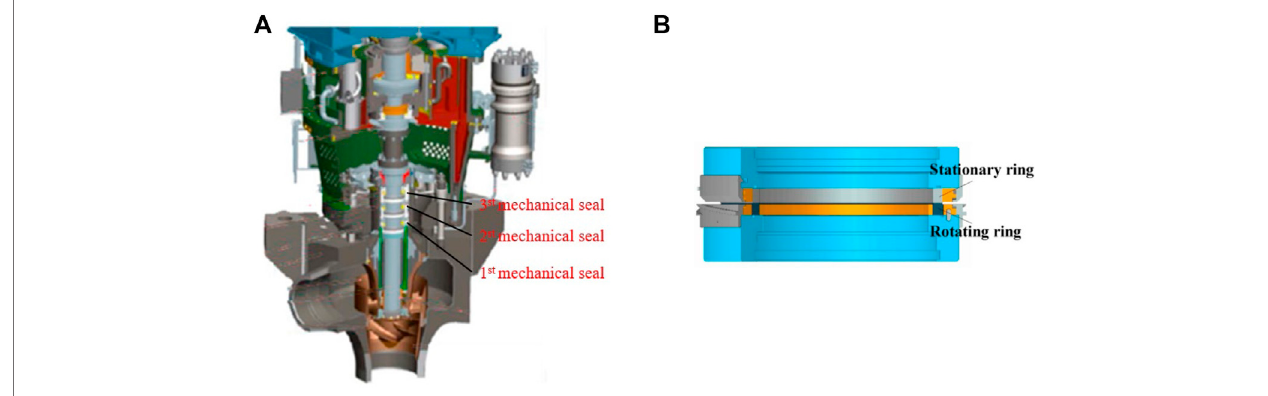
FIGURE 1 | Illustrations of (A) the typical reactor coolant pump and (B) the mechanical seal assembly structure (Su et al., 2020).